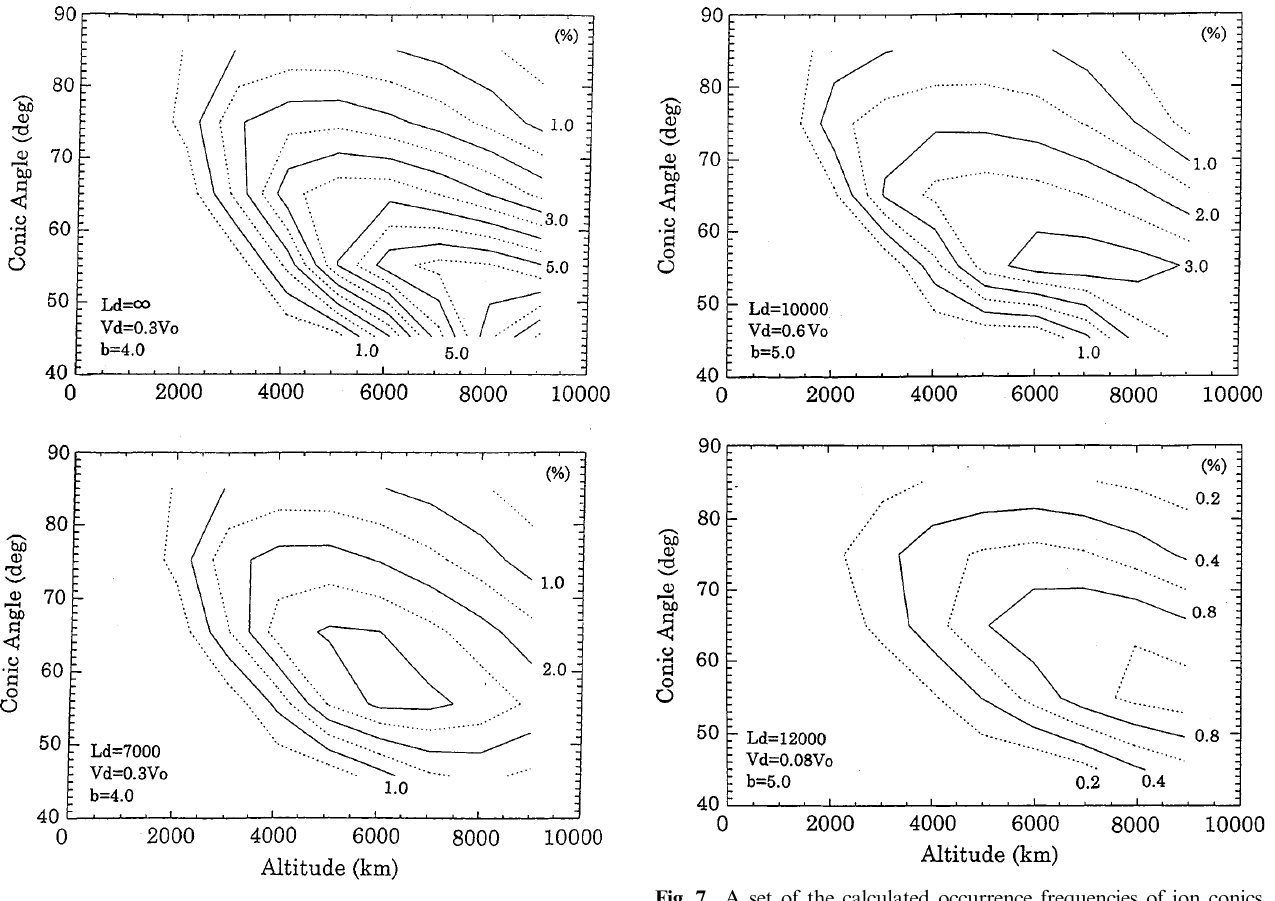
Fig. 6. Two examples of calculated occurrence frequencies as a function of altitude and conic angle. The drift velocity of ions V d is set to be 0 : 3 V o at all the altitudes. Note that the di(cid:128)erence from the case of the drift velocity proportional to r 1 : 5 (Fig. 5) is small